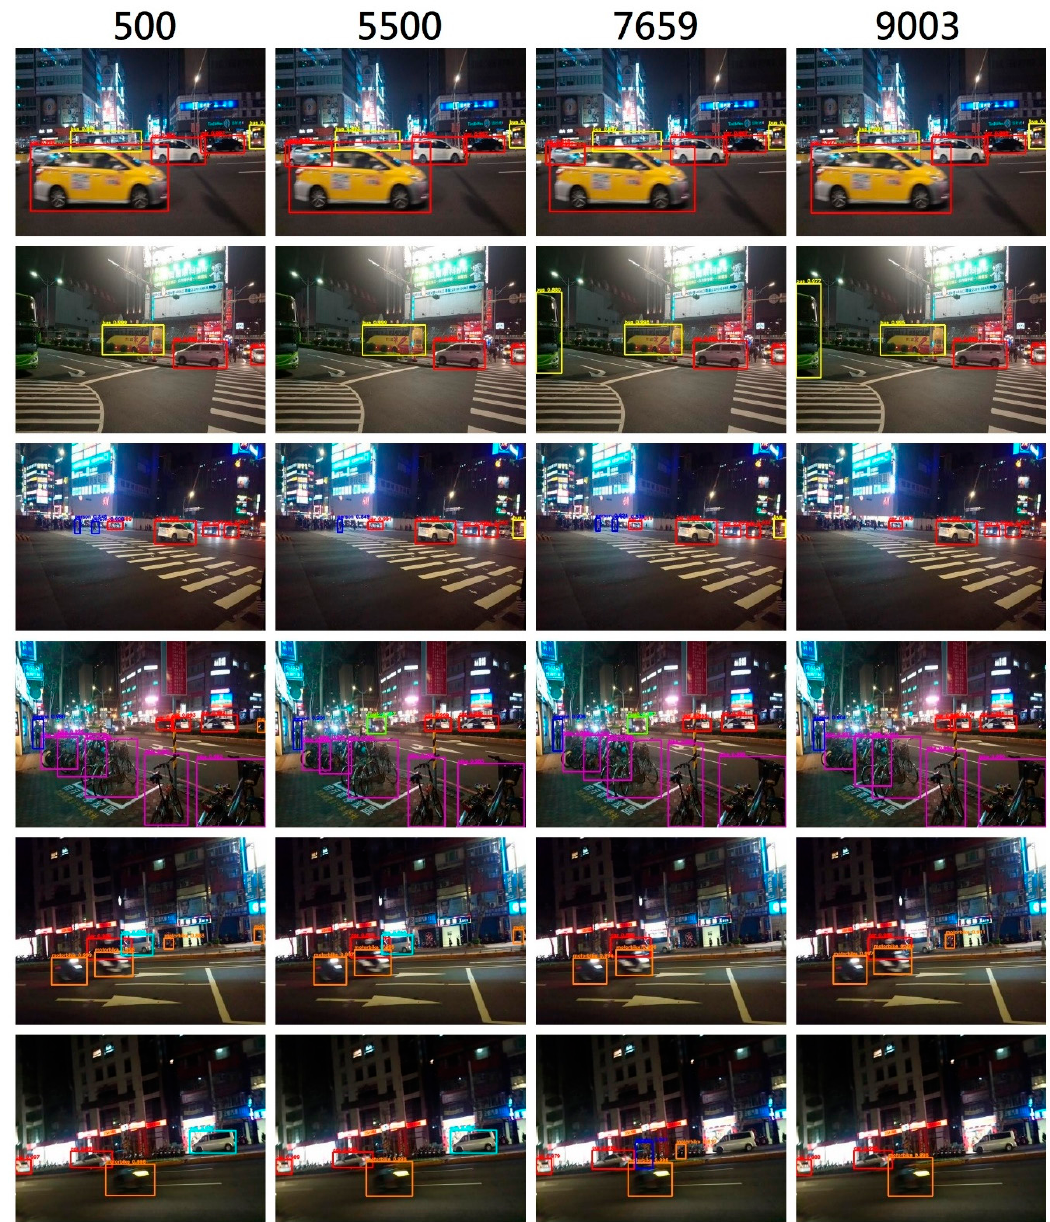
ff erent amounts of our nighttime